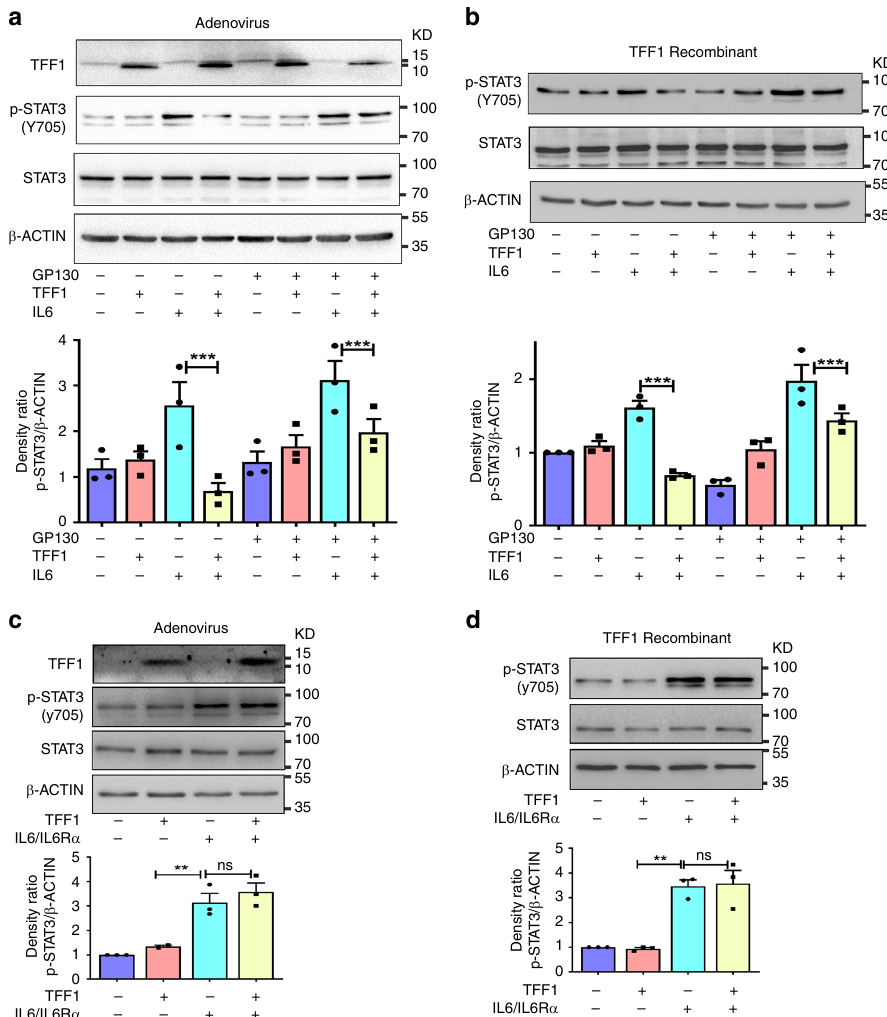
Fig. 8 IL6 – IL6R α soluble complex antagonizes TFF1-mediated suppression of STAT3 activation. a AGS cells were infected with control or TFF1 adenoviruses